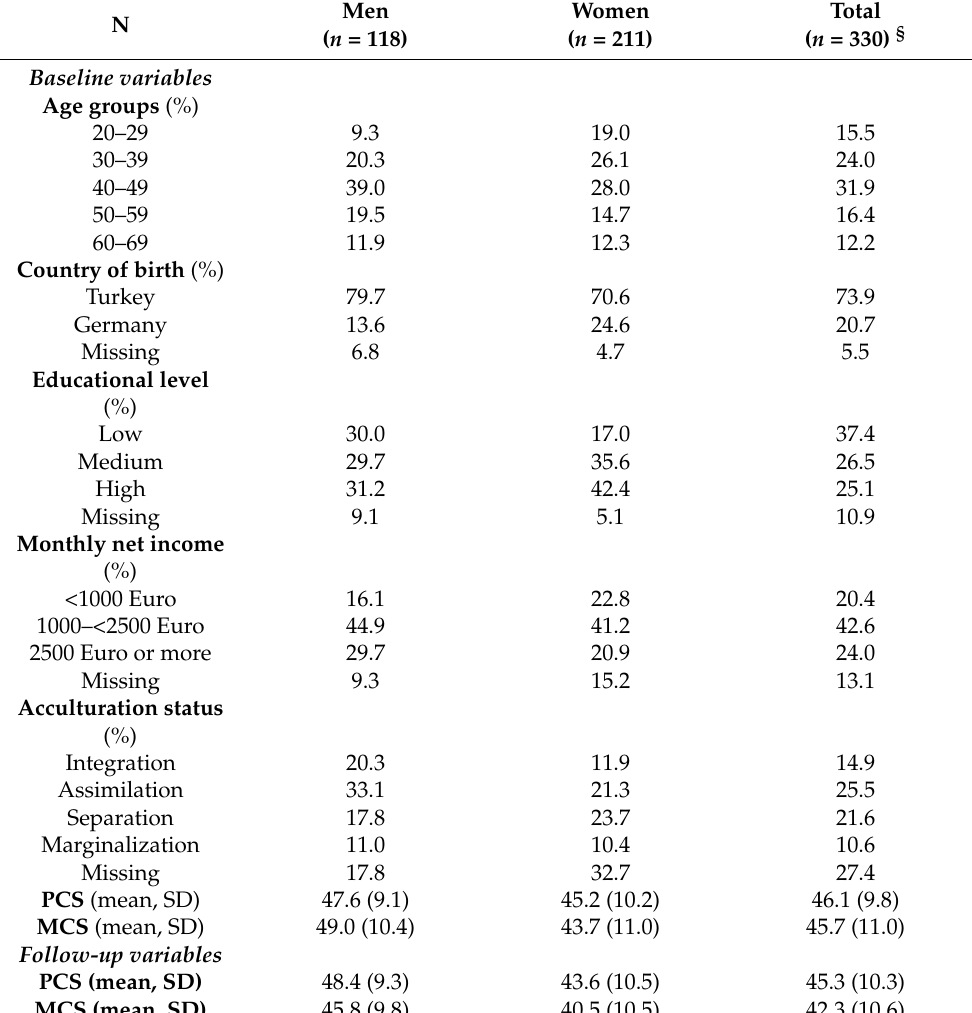
Table 1. Characteristics of study